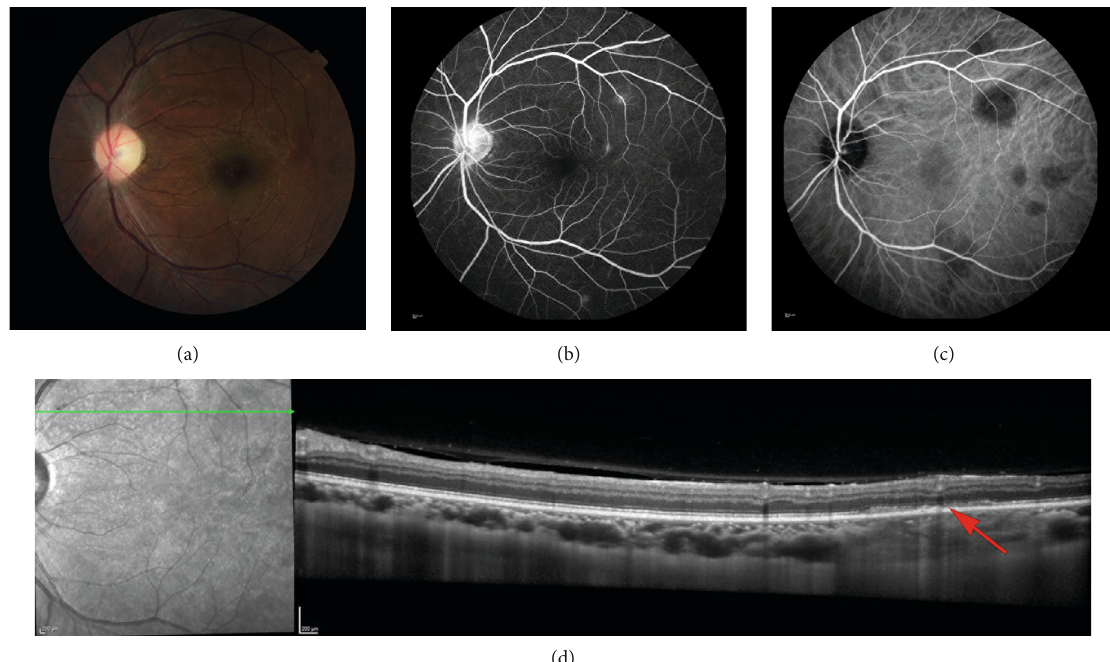
Figure 7: Case 2: left eye at 6-month follow-up. (a) Left eye fundus indicated a signi fi cant regression of the initial lesions with also resorption of hemorrhages and retinal cotton wools. (b) Late-phase FA showed decreased papillary di ff usion with a remaining mild vasculitis on the posterior pole. (c) On ICGA, the hypocyanescent lesions are still present but decreased in size. (d) EDI-OCT showed resorption of the serous retinal detachment (red